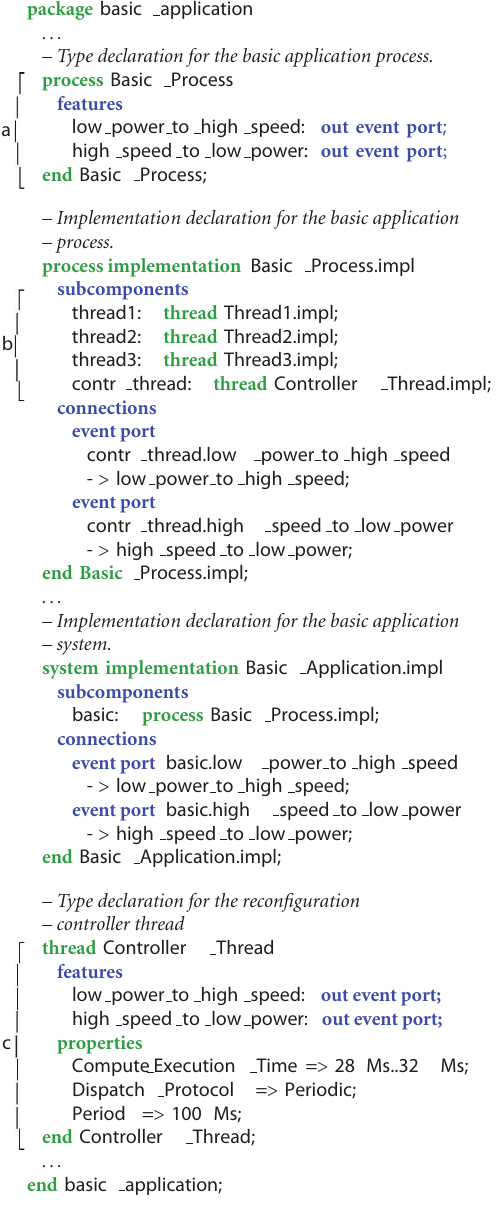
Figure 8: The AADL logical view for a simple software application containing four threads and using dynamic reconfiguration.